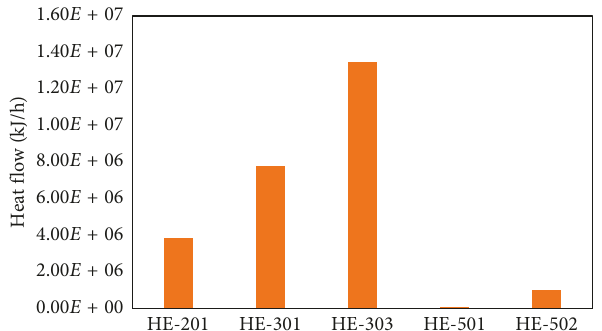
Figure 10: Output heat flow in heat